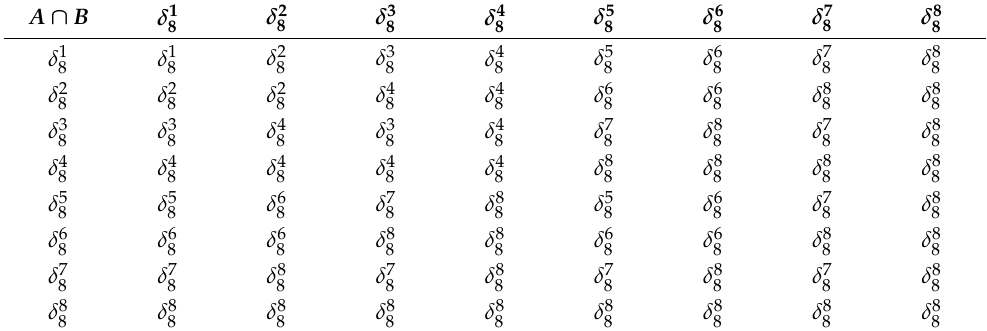
Table 6. Matrix of the intersection of 2 X